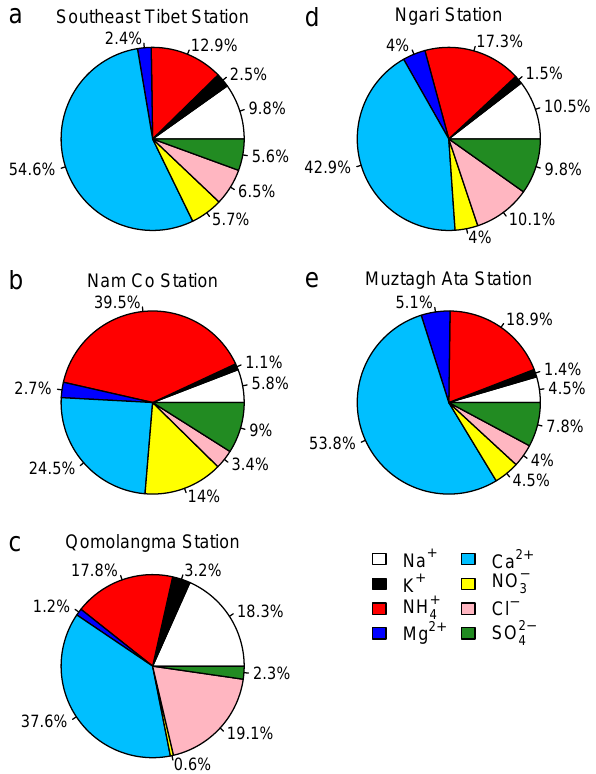
Figure 3. Annual average volume-weighted concentration percent- ages of measured ions in precipitation (unit: µeqL − 1 /µeqL − 1 ) at five remote sites in the TP.